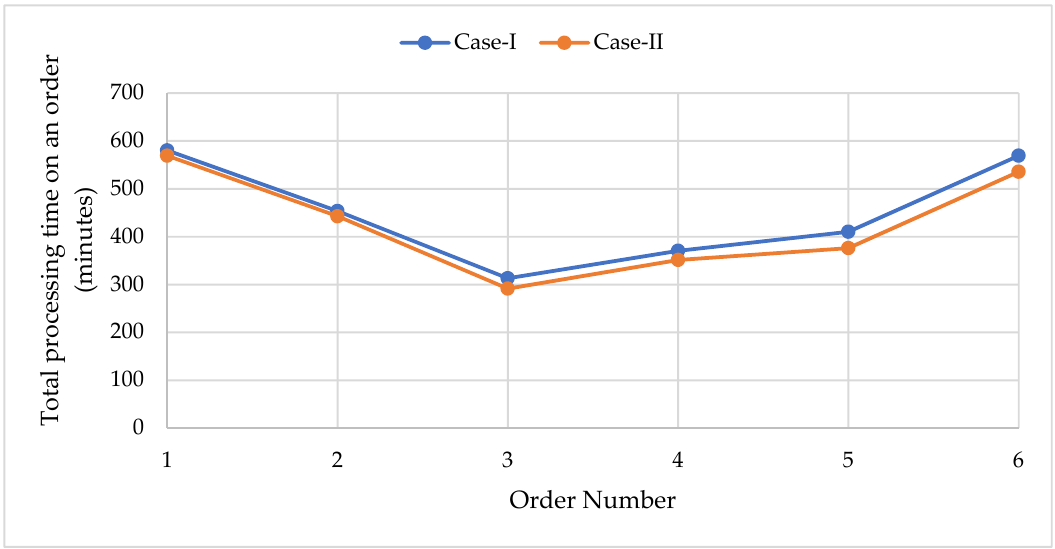
Figure 3. The total processing time on an order in Case-I and Case-II.